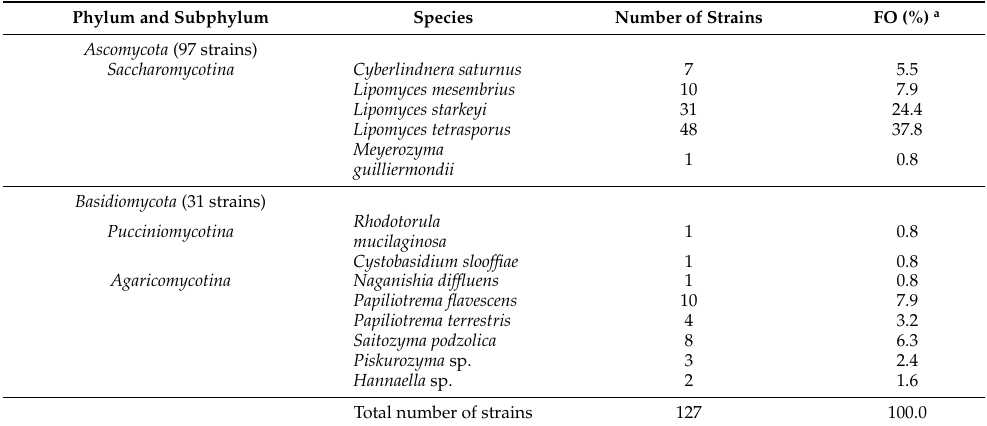
Table 1. Frequency of occurrence of each yeast species isolated from mountain forest